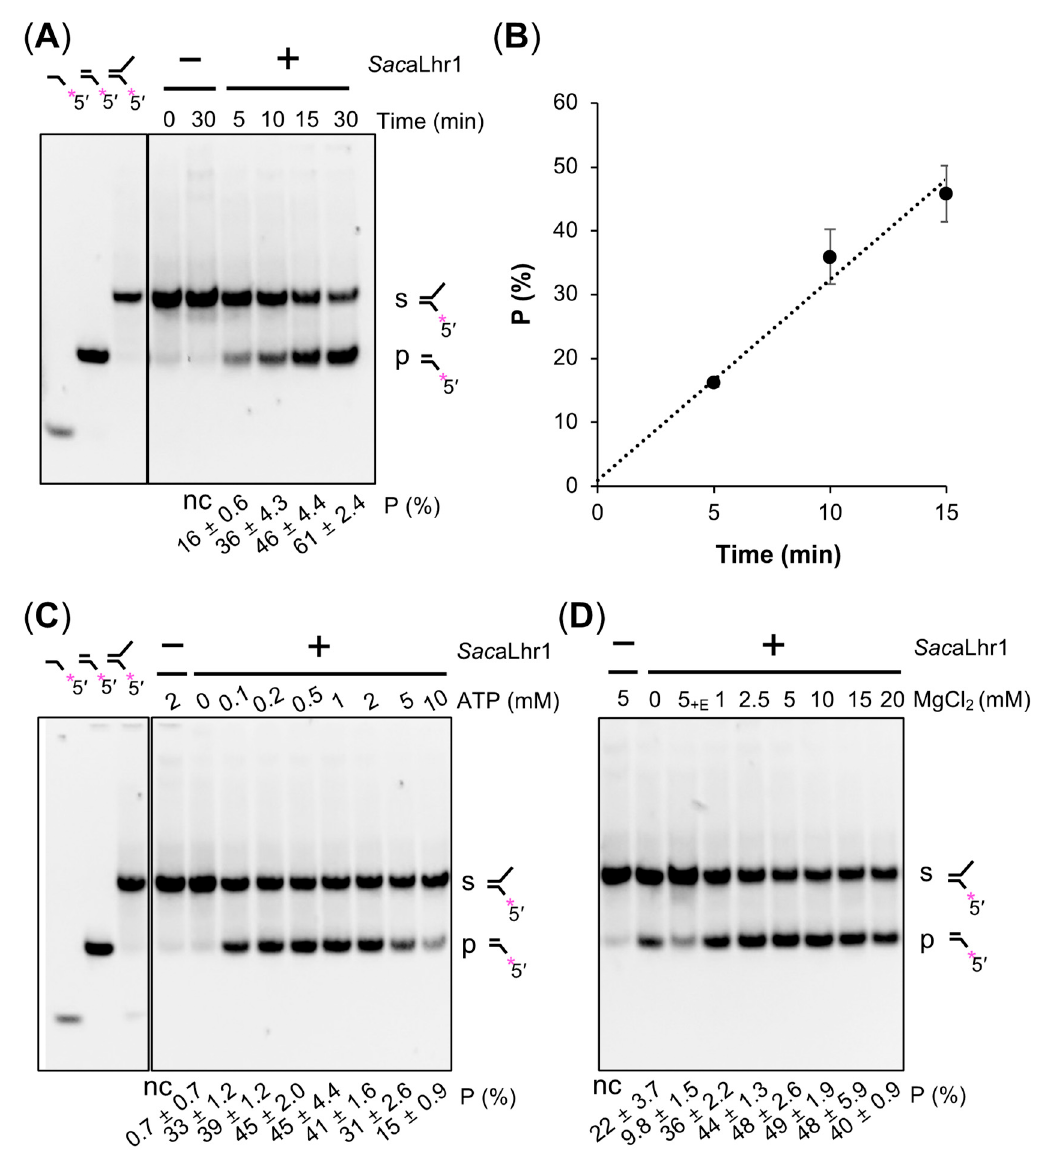
Figure 4. ATP- and Mg 2+ -dependent helicase activity of Sac aLhr1. ( A ) Time-course analysis of helicase activity. Splayed DNA1 (10 nM) was incubated with (+) or without ( − ) Sac aLhr1 (225 nM) at 60 ◦ C for 0–30 min. ( B ) Reactions in ( A ) were quantified and plotted. SD was calculated from three independent experiments. ATP ( C ) and Mg 2+ ( D ) dependences of the helicase activity were examined. Reactions were performed at 60 ◦ C for 15 min in the presence of 5 mM MgCl 2 with indicated concentrations of ATP in ( C ) and 2 mM ATP with indicated concentrations of MgCl 2 in ( D ). +E indicates reaction containing 0.1 M EDTA. Asterisks represent 5 (cid:48) -Cy5 labels. The band assignments are indicated on the right side of the panels, s, substrates; p, products. Reactions were quantified by measuring the band intensities and expressed as P% (product per total DNA) and are indicated under each lane. Value from the negative control reaction without protein (nc, negative control) was subtracted from each value. Data are presented as mean ± SD, calculated from values of three independent experiments.